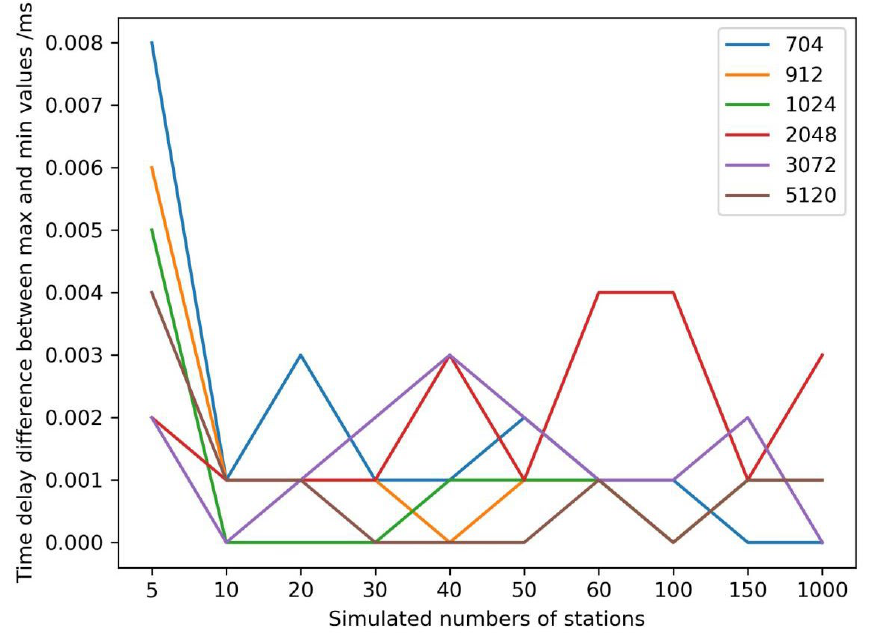
Figure 8. Encryption time delays of different simulated data volumes/bit.